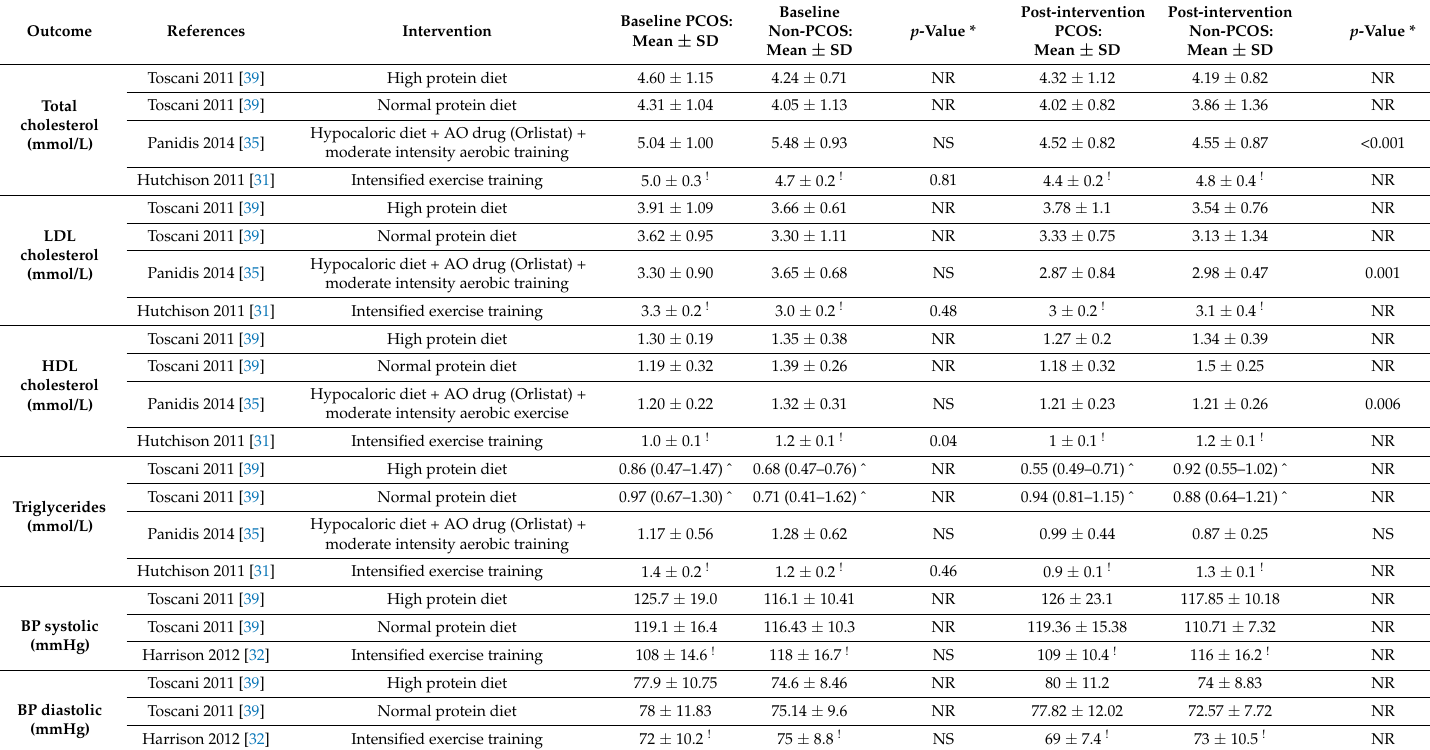
Table 5. Lipids and blood